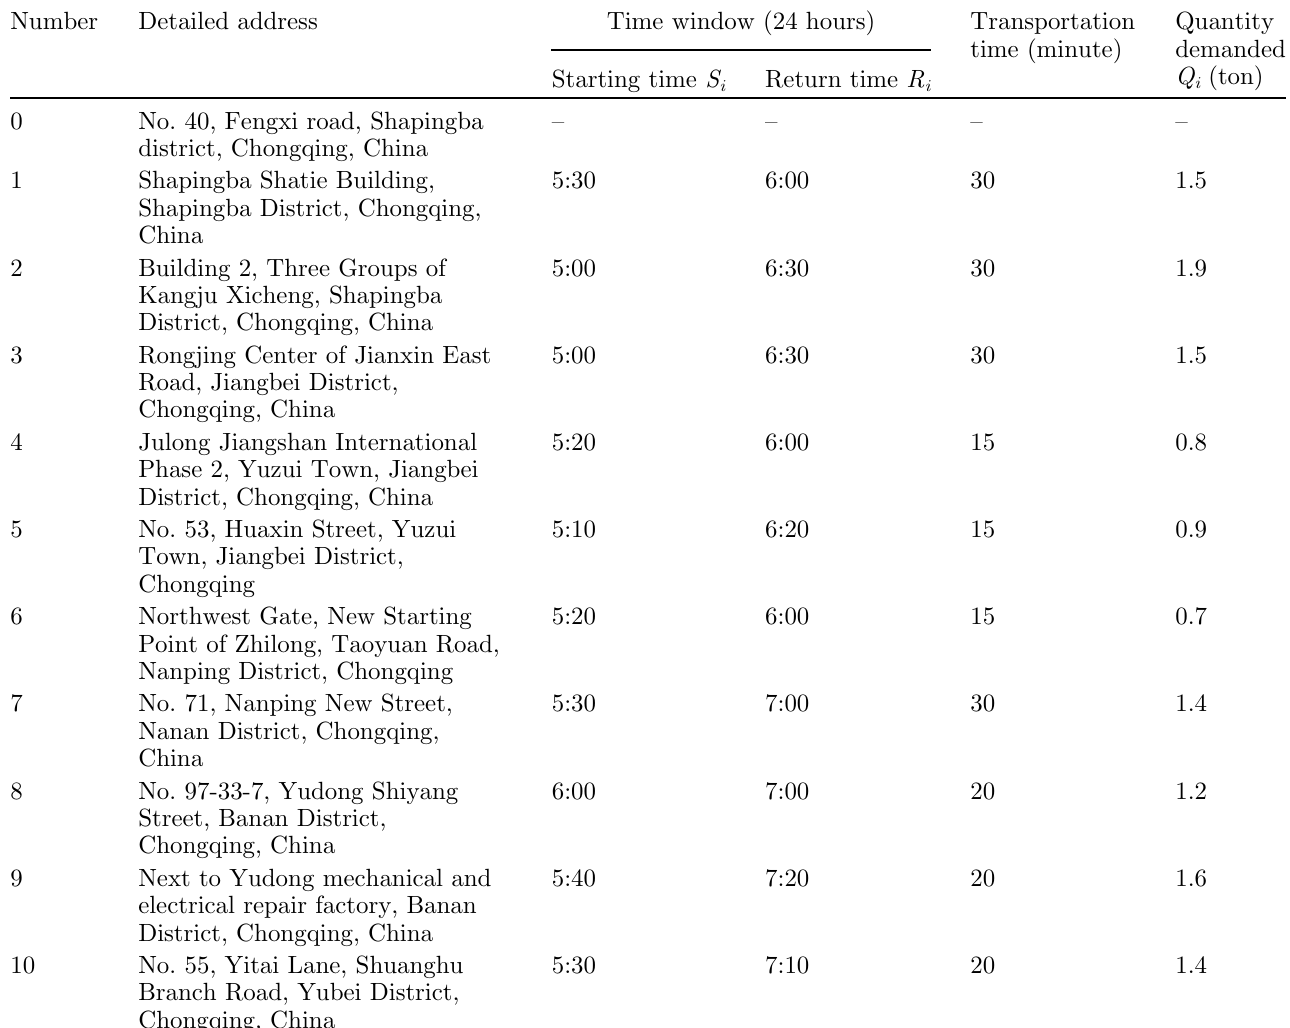
Table 1. Speci fi c information of